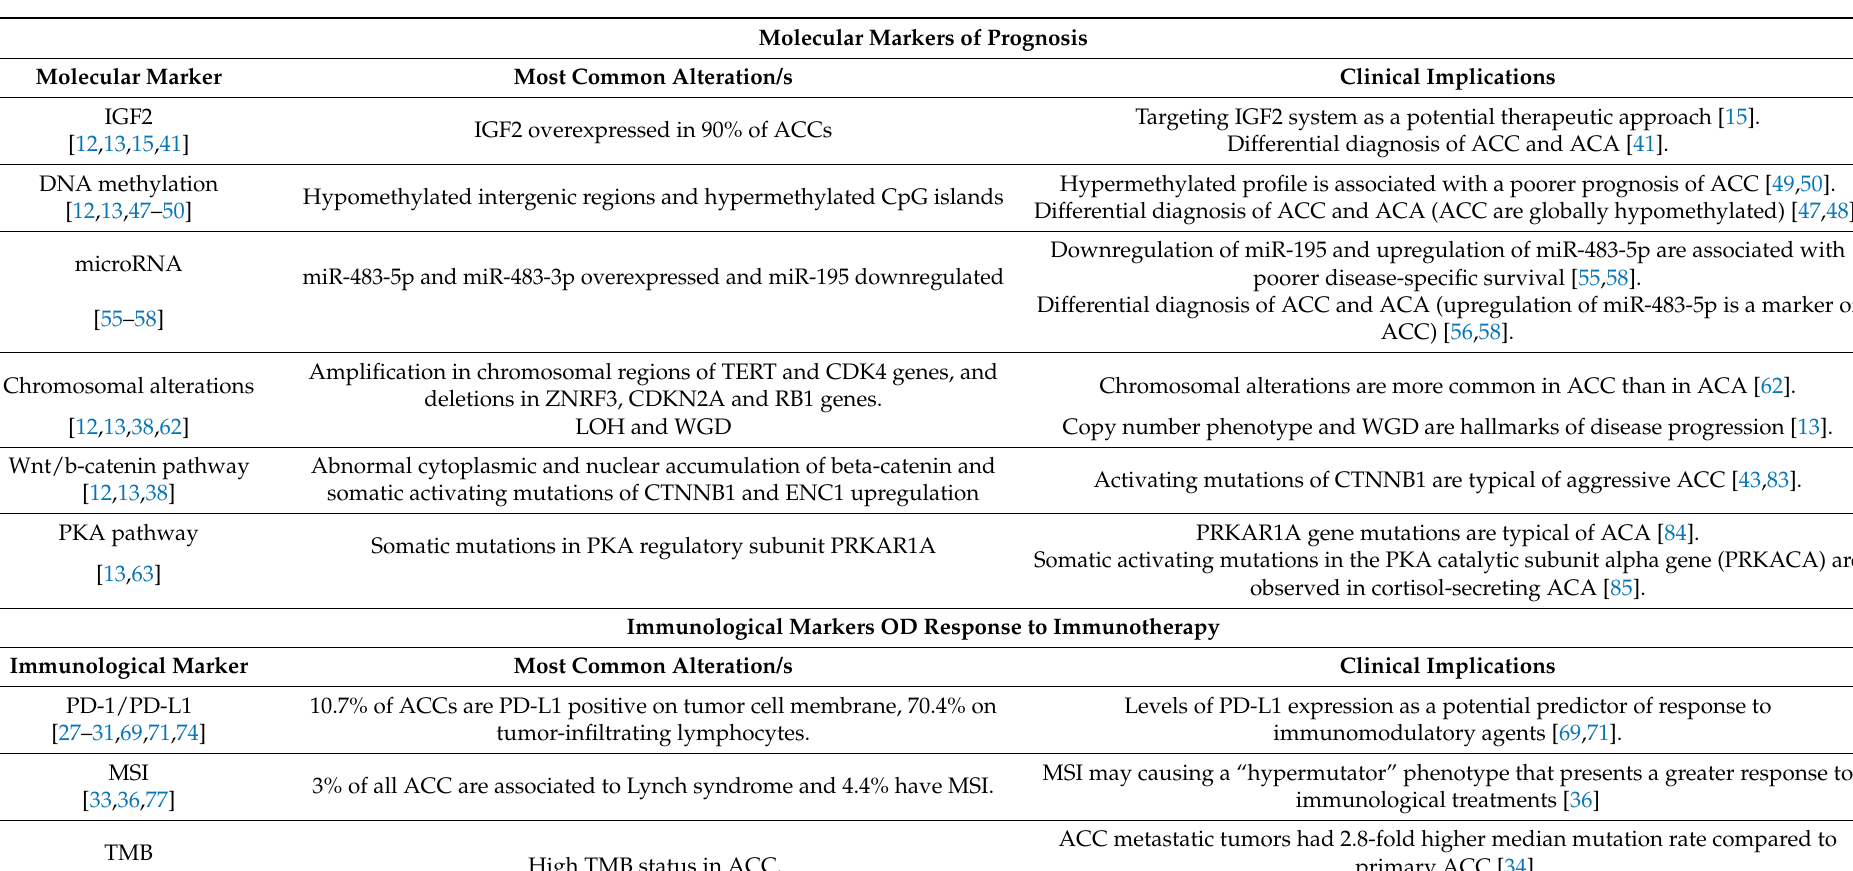
Table 1. Summary of prognostic molecular markers and immunological markers of response to immunotherapy in adrenocortical